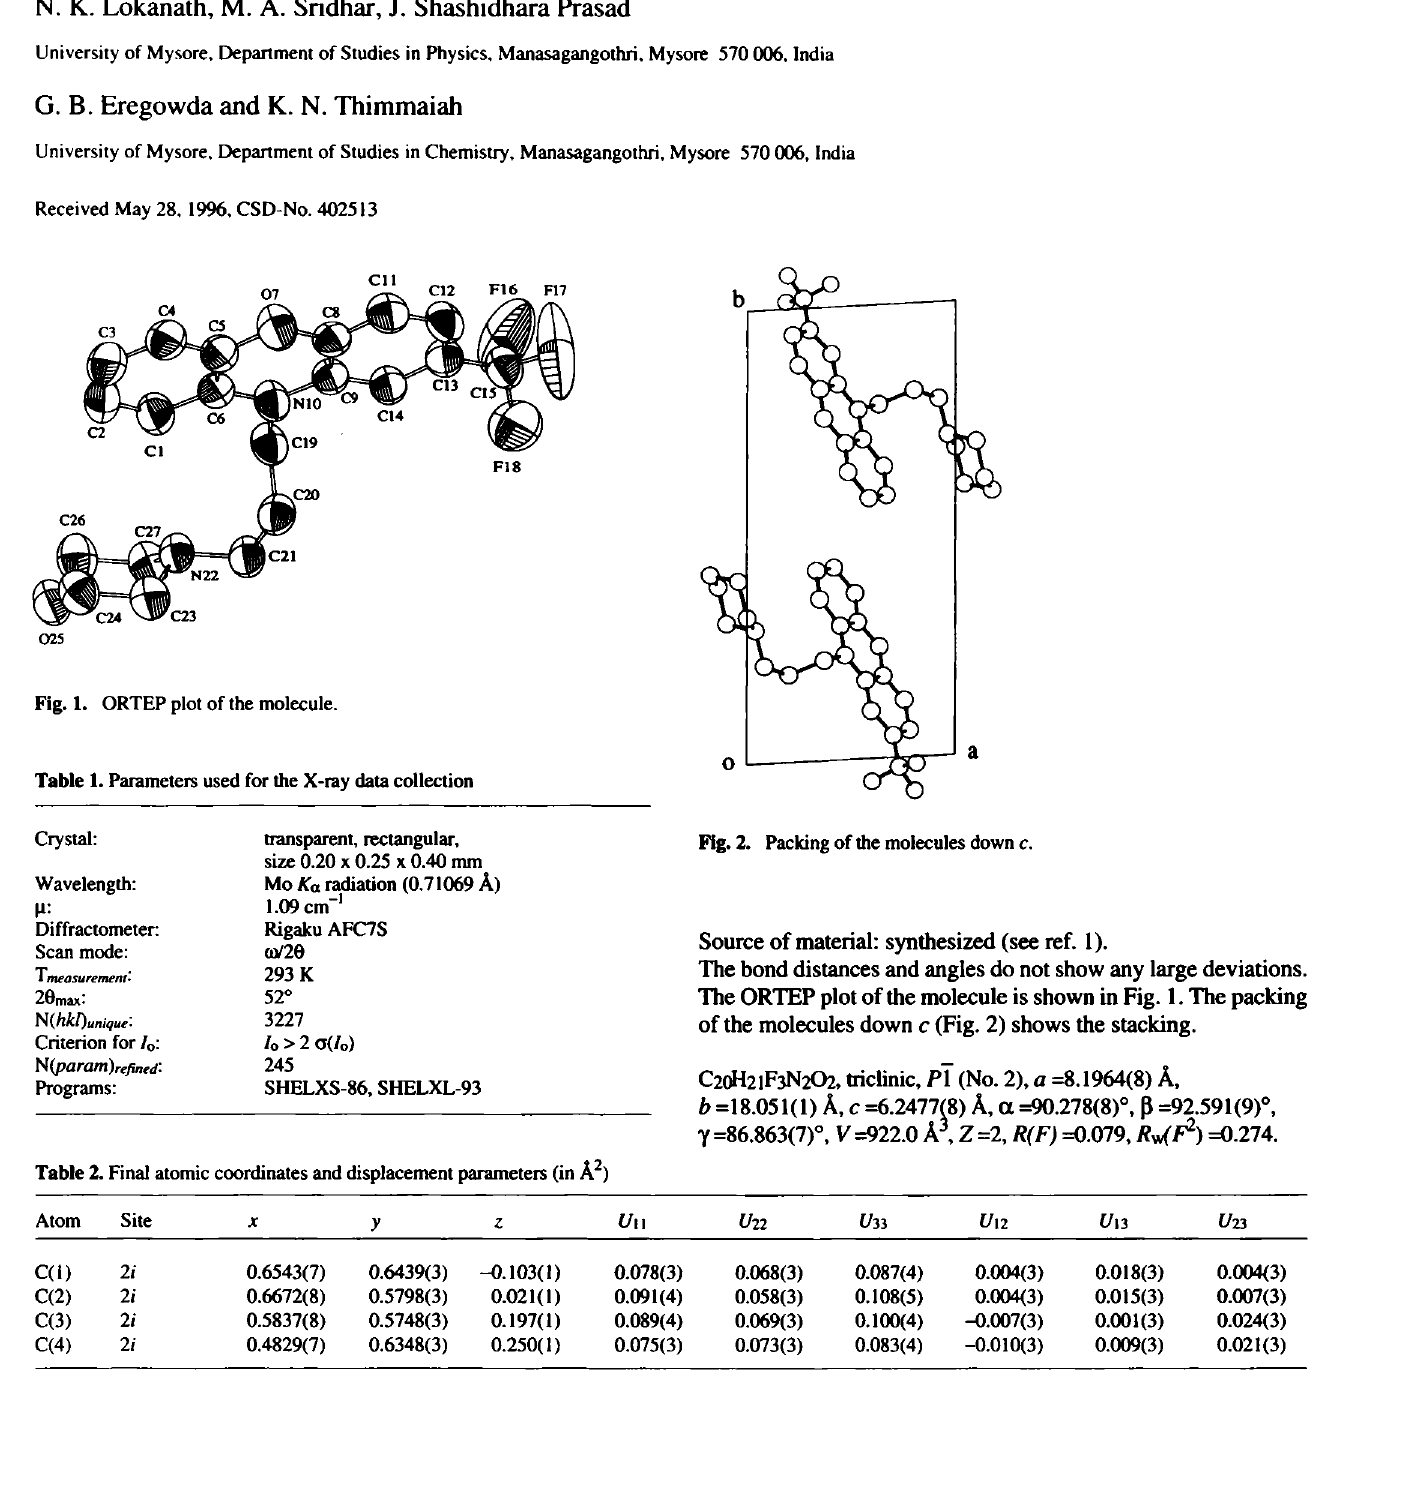
Table 2. Final atomic coordinates and displacement parameters (in Â 2 )